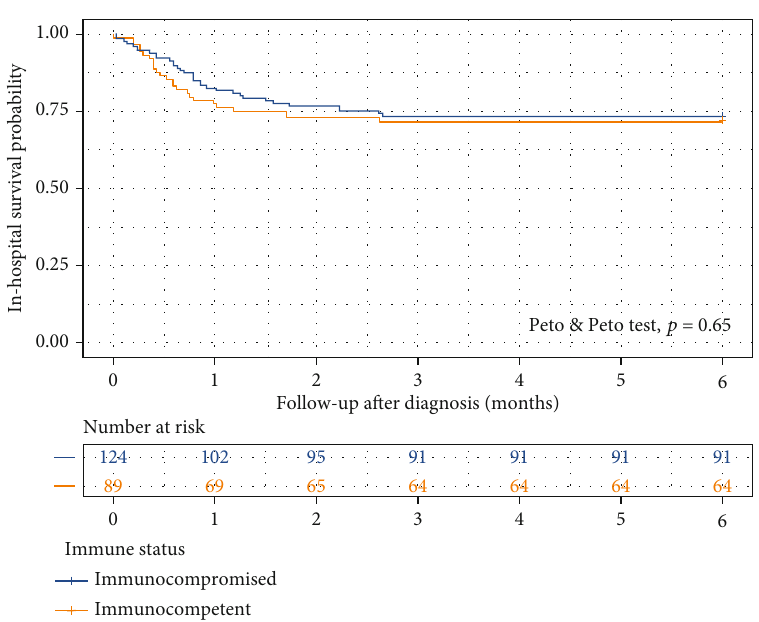
Figure 2: Kaplan – Meier survival curve of inhospital survival probability in immunocompetent and immunocompromised